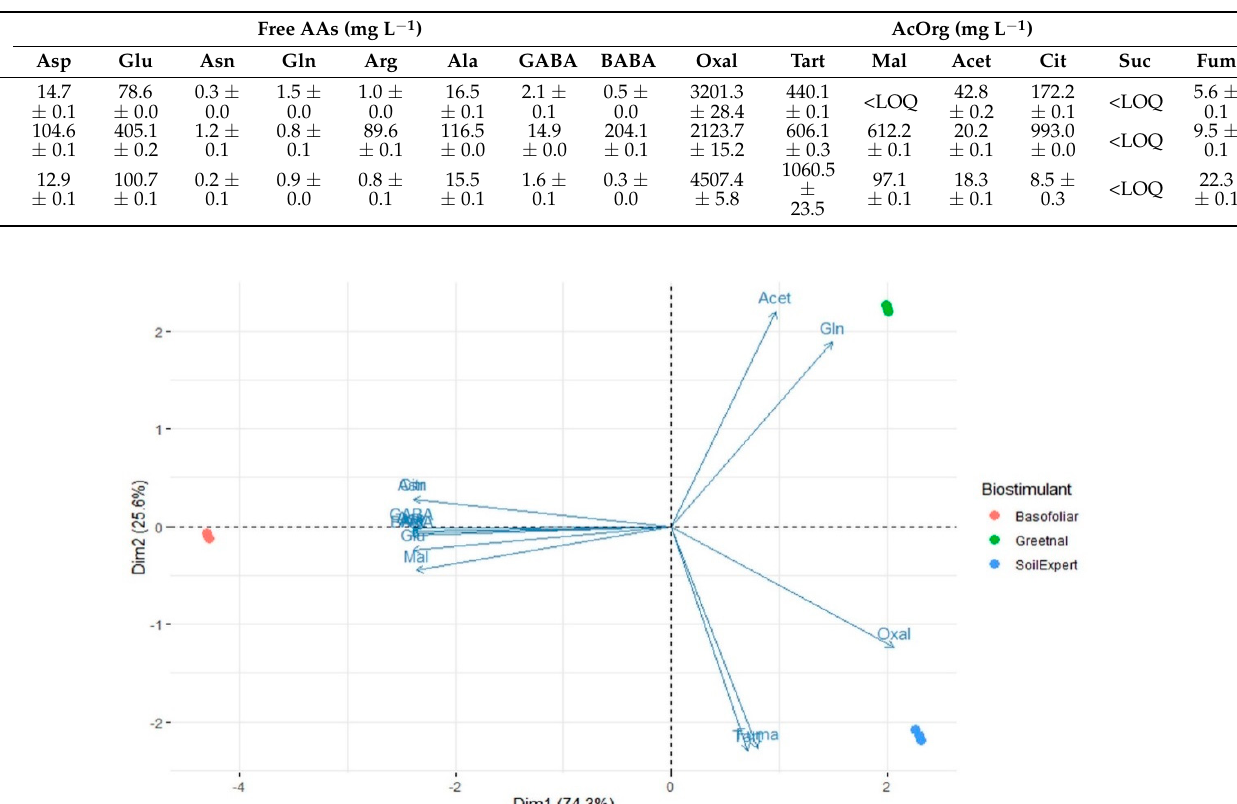
Figure 8. Principal component analysis of the metabolite content in three commercial biostimulants (Greetnal (GT), Basofoliar (BF), or SoilExpert (ST)).